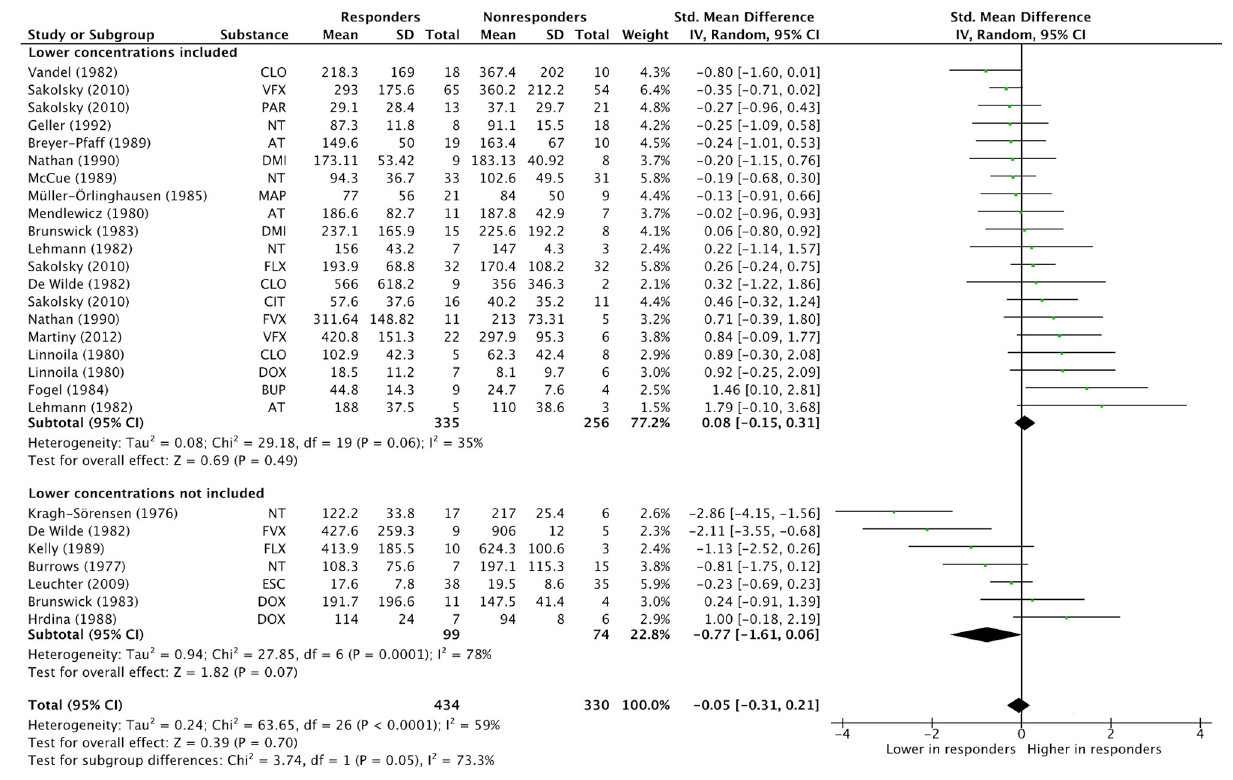
FIGURE 4 | Subgroup analysis “Lower concentrations included”. Overall effect estimates across N treatment arms = 27, in N = 19 studies. AT, Amitriptyline; BUP, Bupropion; CIT, Citalopram; CLO, Clomipramine; DMI, Desipramine; DOX, Doxepin; ESC, Escitalopram; FLX, Fluoxetine; FVX, Fluvoxamine; MAP, Maprotiline; NT, Nortriptyline; PAR, Paroxetine; VFX,